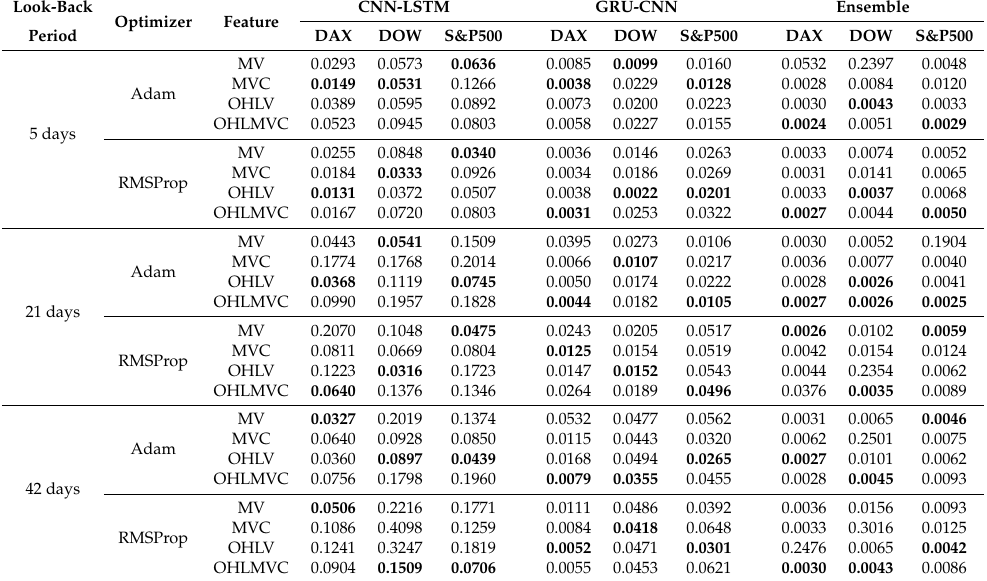
Table 7. Comparison of different optimizers and features in terms of average MSE over the three periods for five-time-step prediction. Look-Back CNN-LSTM GRU-CNN Ensemble Optimizer Feature Period